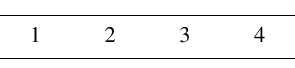
Table 2. The k -means clusters based on principal component load- ings of SCD anomalies.